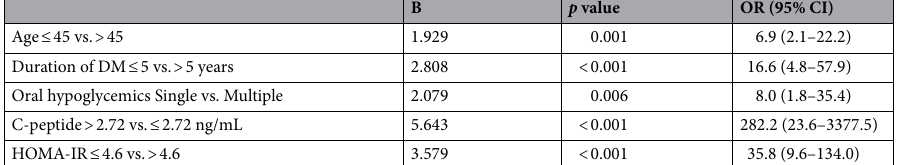
Table 6. Independent factors linked to complete remission of T2DM 2 years after LSG using logistic regression. B regression coefficient, OR odds ratio, CI confidence interval, HOMA-IR homeostatic model assessment of insulin resistance.